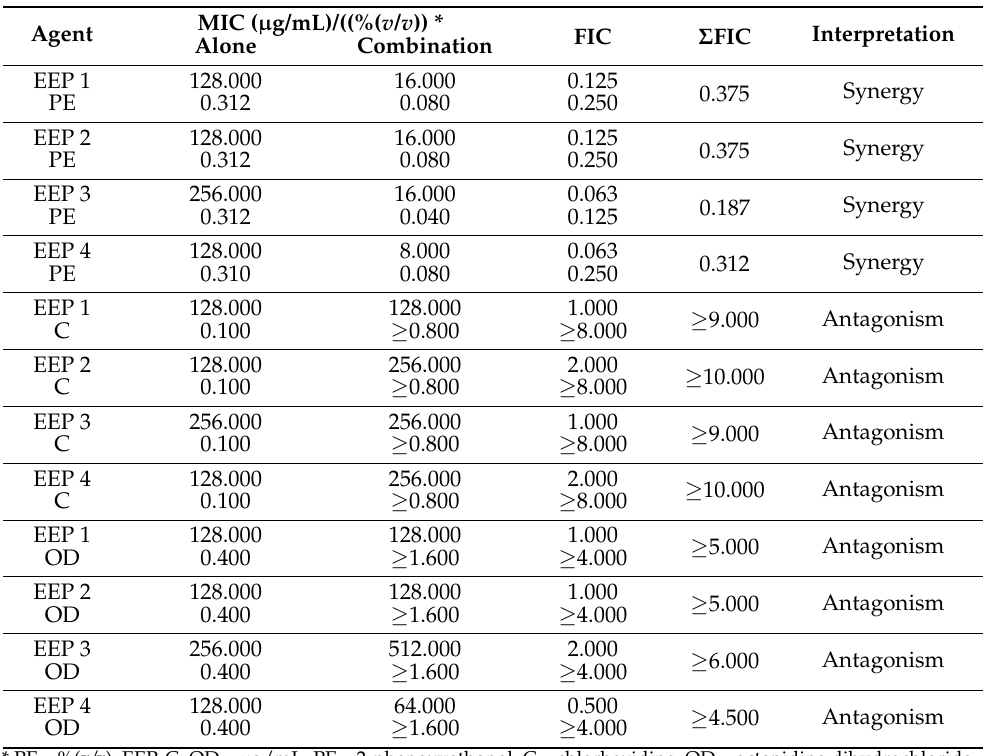
Table 3. The checkerboard analysis of drug interaction between EEPs and different antiseptic against